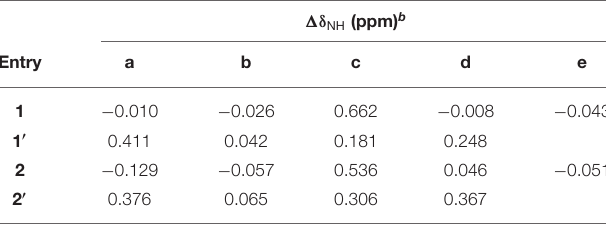
TABLE 1 | Difference in the chemical shifts of amide protons at low and high concentrations a